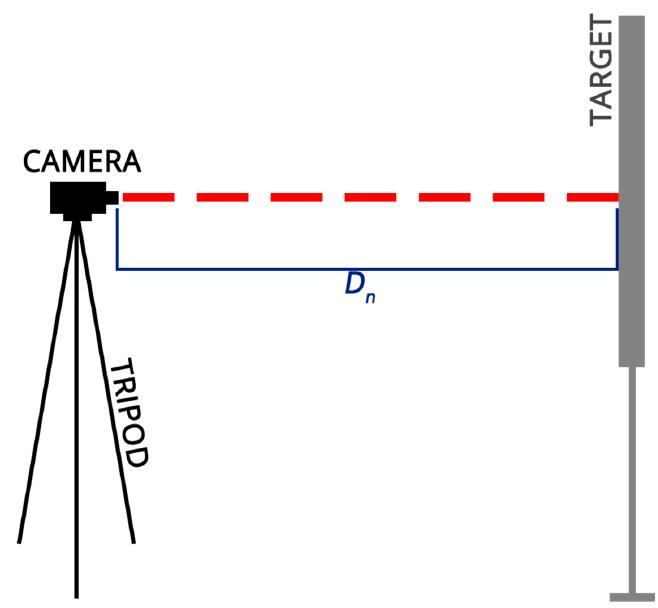
Figure 1. Scheme of the measuring set-up.